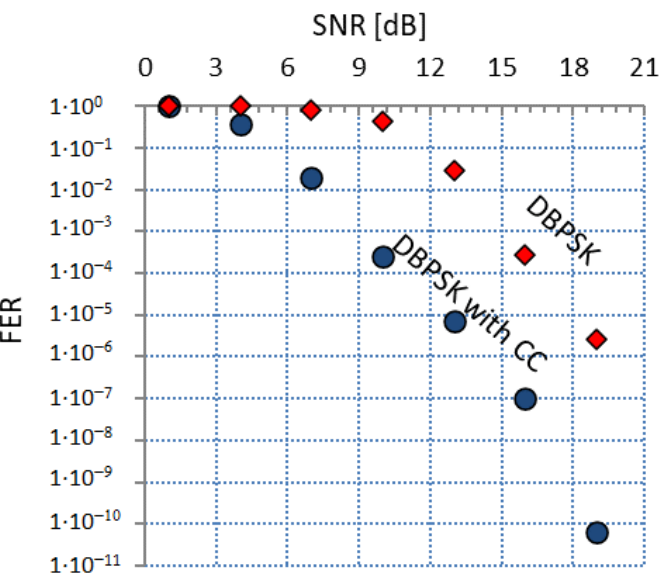
Figure 2. FER vs. SNR characteristics, for DBPSK with CC and DBPSK without CC modulations, performed with a frame size of 18 bytes.